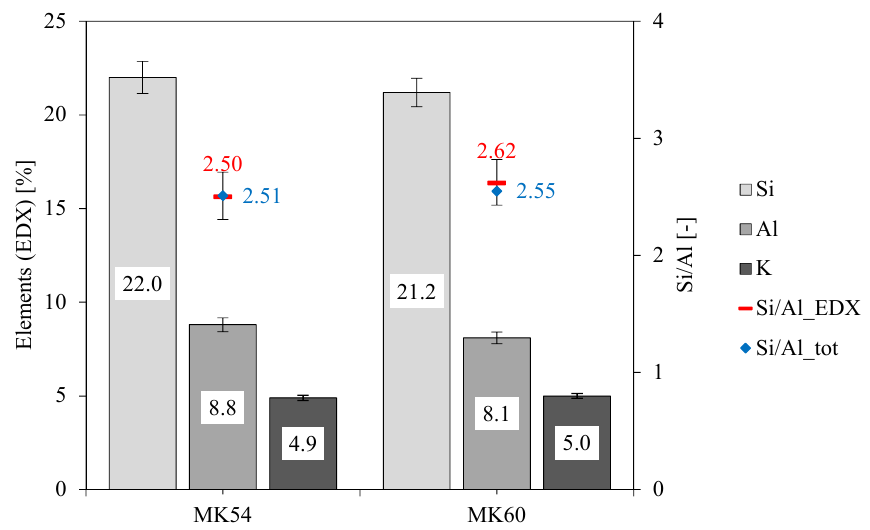
Figure 4. Percentage element distribution for Si, Al, K, and Si / Al ratios obtained from SEM-EDX elemental mapping and from the chemical composition of geopolymer formulation (Si / Al tot ) for geopolymers MK54 and MK60.